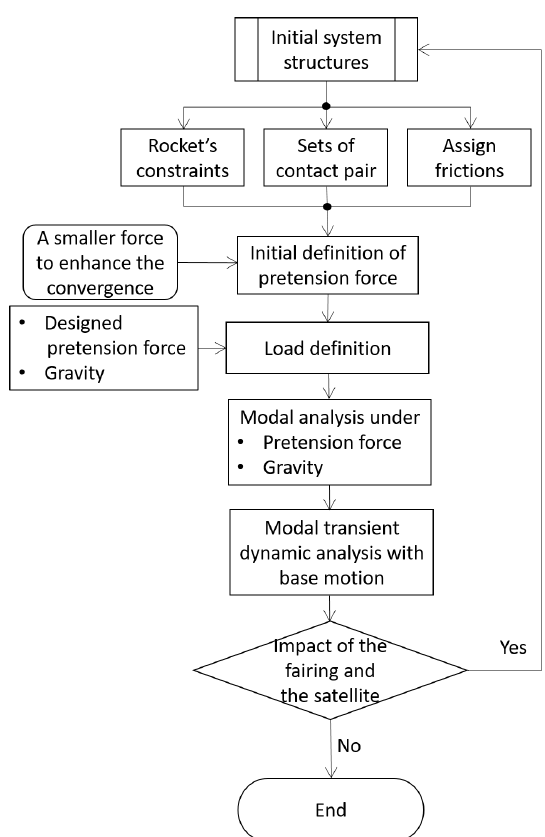
Figure 9. The scheme of the safety analysis of the